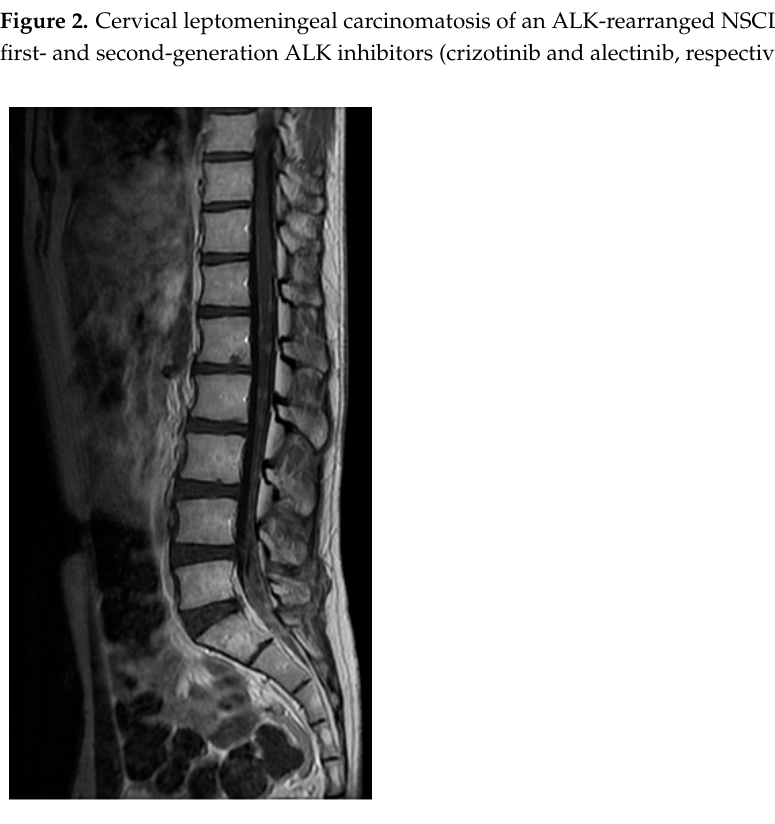
Figure 3. Leptomeningeal metastases of the cauda equina from a BRAFv600-mutated melanoma.